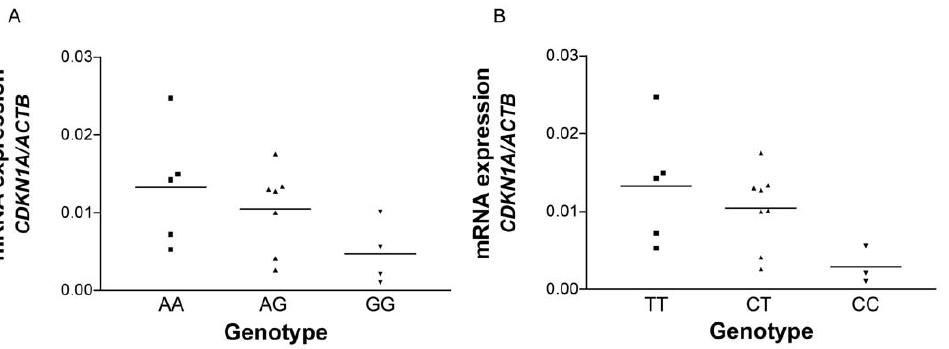
Figure 3. CDKN1A mRNA expression in healthy controls. CDKN1A mRNA levels were significantly different between rs733590 genotypes, p=0.03 (TT + CT vs. CC). A similar trend was observed for rs2395655 genotypes (p=0.06, AA + AG vs.